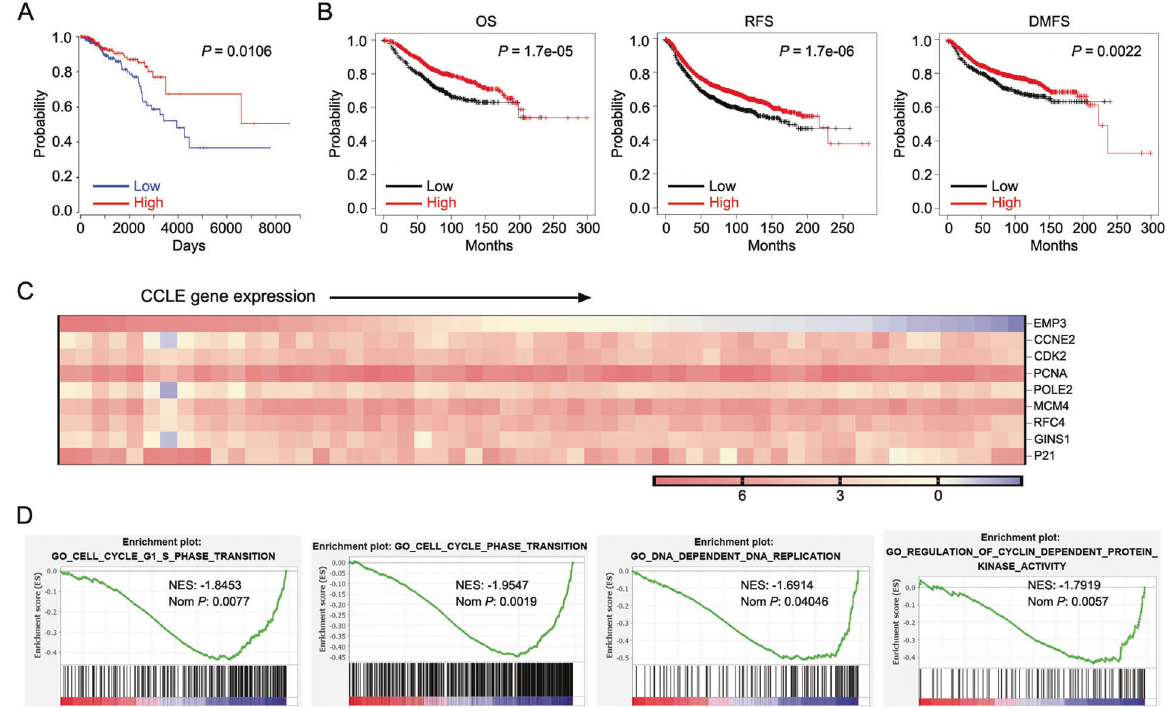
Fig. 1 In silico analysis suggests EMP3 as a tumor suppressor in breast cancer. A The association of EMP3 with OS was analyzed in the TCGA database. B The association of EMP3 with OS, RFS, and DMFS was analyzed in Kaplan – Meier plotter website. C A heat map was generated from the CCLE database demonstrating the correlation of EMP3 with factors related to the S-phase. D Go analysis of the gene pathways differentially expressed between EMP3-high and EMP3-low breast cancer samples in the TCGA database was performed. Four representative GSEA-enrichment plots were